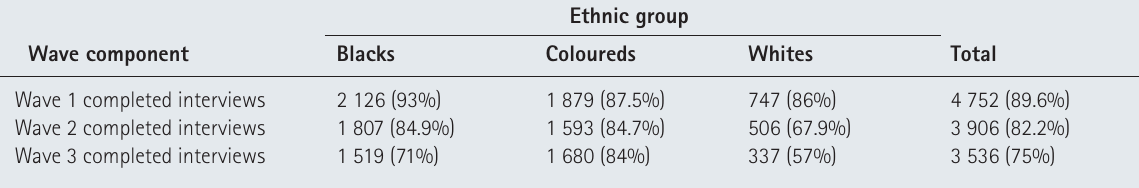
TABLE I. REspONsE RATEs fOR WAVEs 1, 2 AND 3 (REspONsE RATEs ARE IN